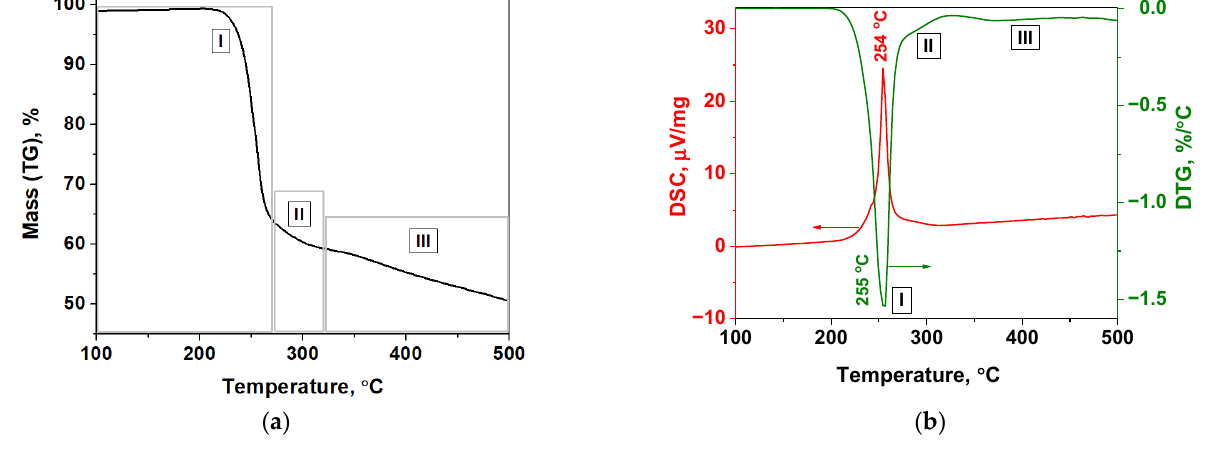
Figure 4. ( a ) Integral TG, ( b ) DTG and DSC curves according to the thermal analysis of [Ni(En) 3 ](ClO 4 ) 3 decomposition in helium with β = 5 °C·min − 1 .